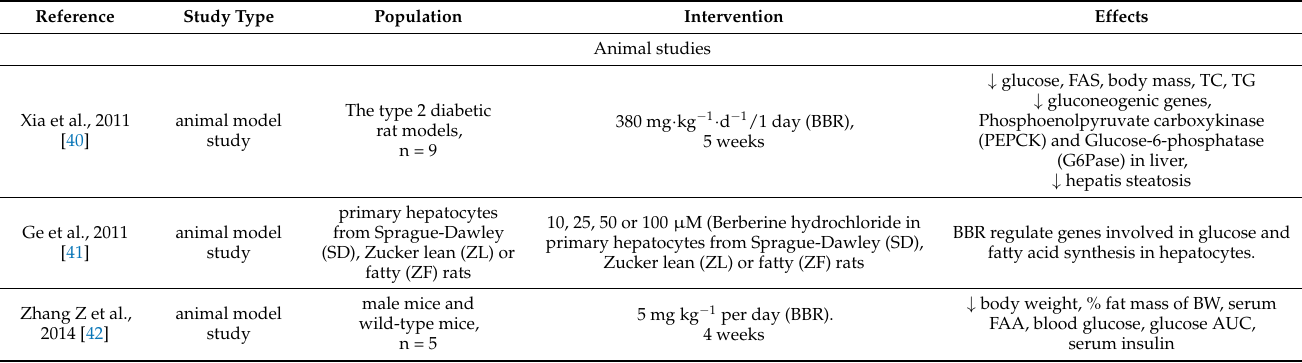
Table 1. Effects of BBR presented in animal and clinical